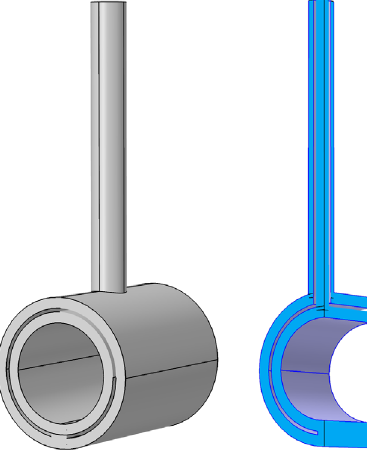
FIG. 7. Left: A 3D view of the cooling channel of a NIMMS facility structure drift tube. Right: Cooling channel cut in the symmetry planes. The area shown in blue is the water passage. Inner connections are clearly